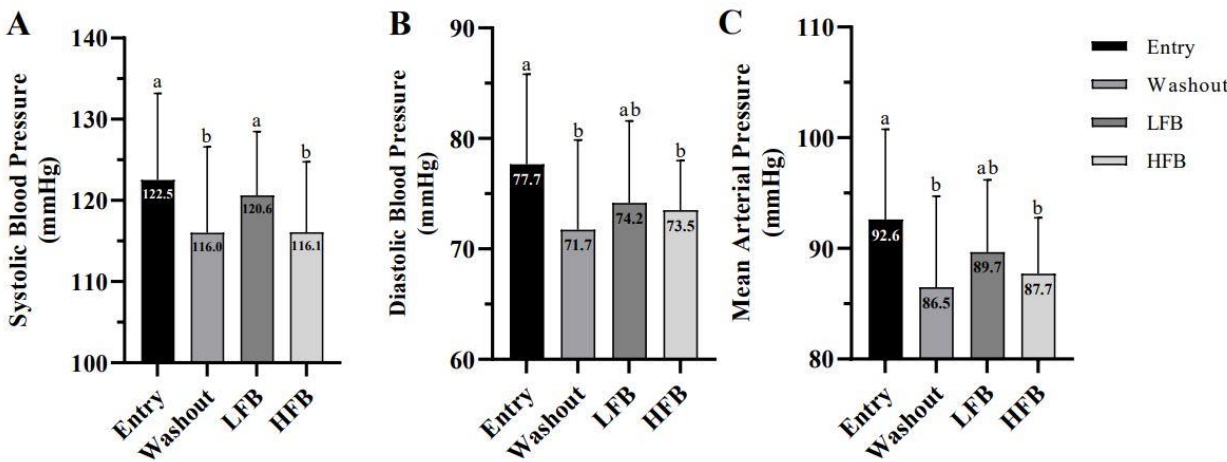
Figure 3. ( A ) Resting systolic blood pressure. ( B ) Resting diastolic blood pressure. ( C ) Mean arterial pressure. Values are for entry, washout, LFB intervention, and HFB intervention. Cross-over design ( n = 21); values represent mean ± SD. Means without a common letter differ, p < 0.05.